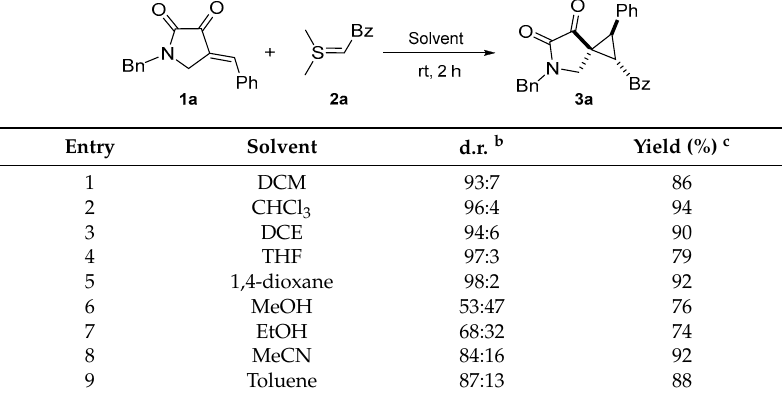
Molecules 2017 , 22 , 328 3 of 17 Table 1. Screening studies of the cyclopropanation reaction a .